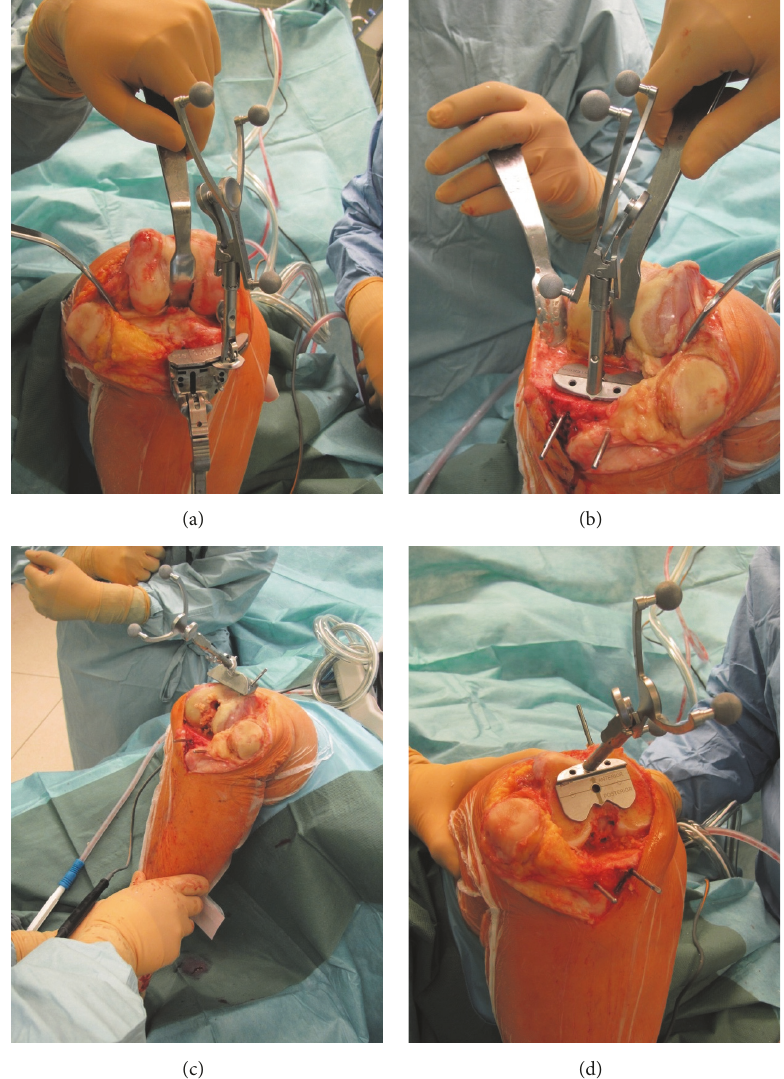
Figure 1: Surgical procedure using the “pinless verification” workflow of the DASH system. (a) Cutting block verification at the proximal tibia, (b) cut verification at the proximal tibia, (c) cutting block verification at the distal femur, and (d) cut verification at the distal